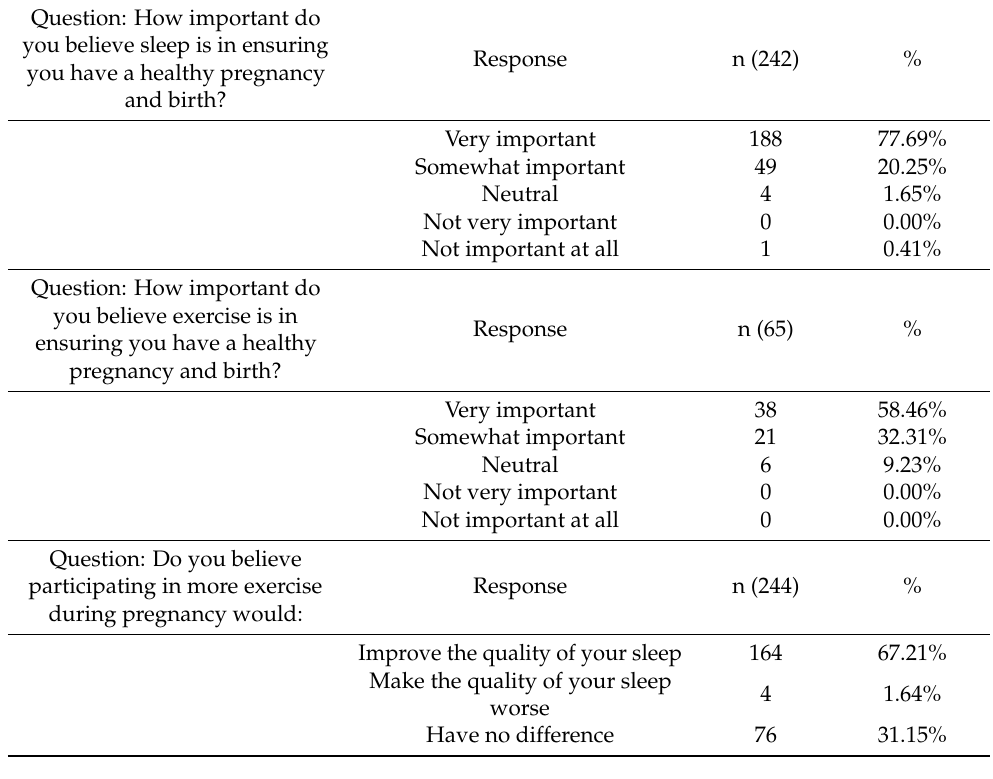
Table 2. Beliefs surrounding the importance of sleep and exercise during pregnancy.